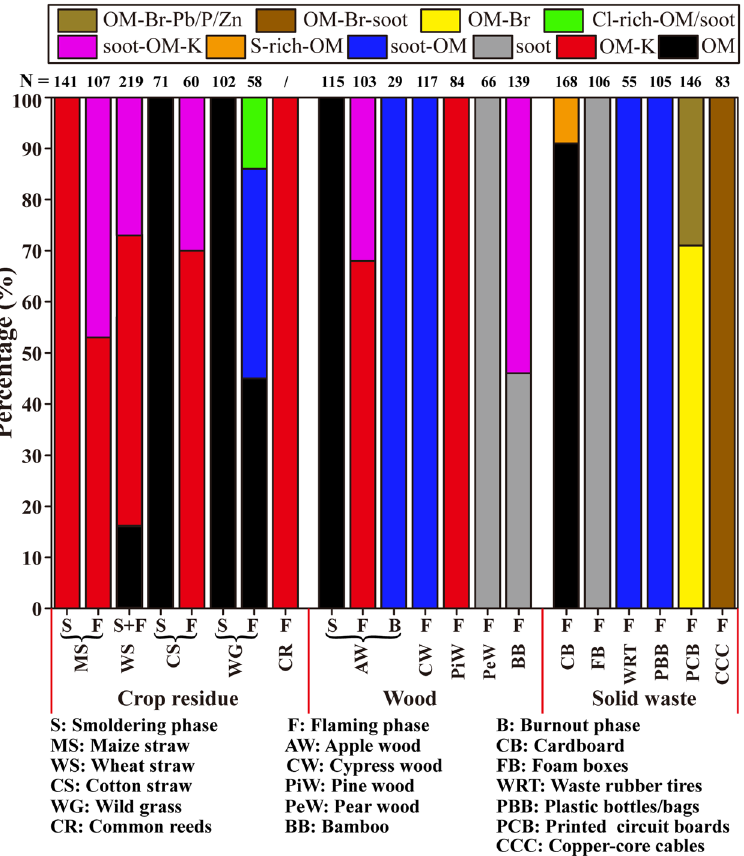
Figure 10. Percentages of typical primary particles emitted from different materials’ combustion with the smoldering and flaming phases. The number of the analyzed particles is shown above each column. The particle number of common reeds cannot be counted because the gel-like OM particles were in contact with each